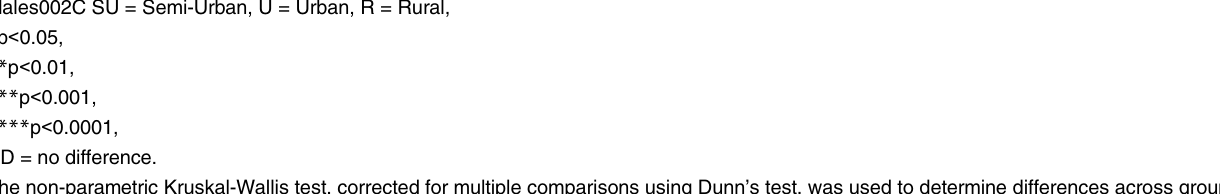
of CD8 T cells (median of 23 versus 25%). Furthermore, they had lower absolute counts of CD3-expressing cells (1373x10 3 versus 1506x10 3 cells/ μ l), CD8 T cells (median of 455x10 3 ver- tively) than the semi-urban male blood bank participants. Urban male vaccine study participants had significantly higher T cell percentages than men in the rural Kayunga cohort study, but significantly lower NK cell percentage and absolute count (Table 3; p < 0.01). Interestingly, women displayed fewer differences across the three cohorts compared to men (Table 4). The urban female vaccine study participants had significantly higher percentage of CD4 T cells (median of 74 versus 72%), but significantly lower percentage and absolute count of NK cells (median of 9 versus 11% and 184x10 3 versus 263x10 3 cells/ μ l, respectively) com- pared to semi-urban blood bank study female participants (Table 4, all p < 0.05). The rural Kayunga cohort female participants had a significantly higher percentage of CD4 T cells (median of 46 versus 43%), higher CD4/CD8 ratio ([median of 2.03 versus 1.71], Table 4, both p < 0.05), but lower percentage of CD3-expressing cells (median of 71 versus 72%) and CD8 T cells (median of 22 versus 24%) and CD8 absolute counts ([median of 507x10 3 versus 579x10 3 cells/ μ l], Table 4, all p < 0.05) compared to semi-urban blood bank study female participants. Additionally, women from the rural Kayunga cohort study had a significantly lower percentage of CD8 T cells (median of 22 versus 24%), but significantly higher NK cell percentage (median